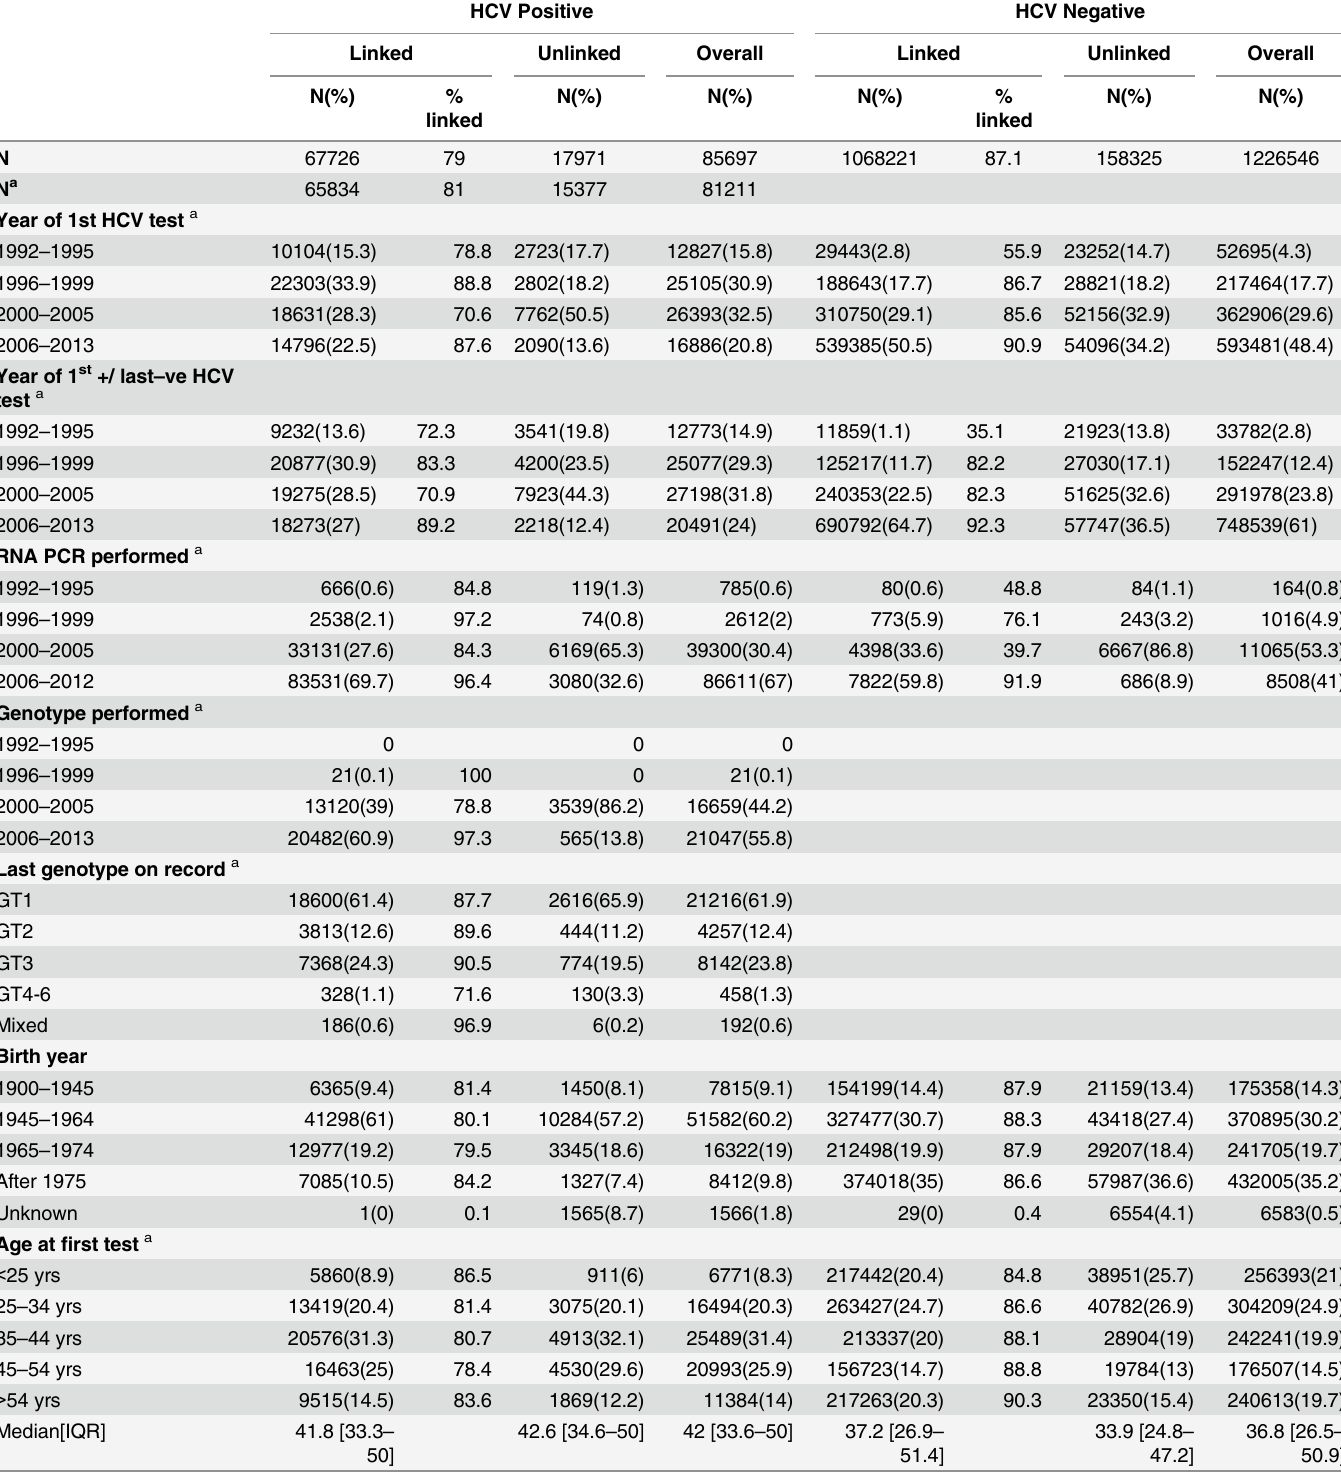
Table 3. Comparison of linked and unlinked HCV